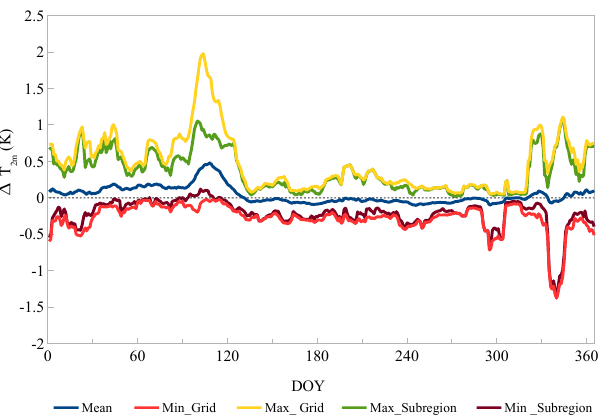
Figure 6. Maximum, minimum and mean differences of grid point- wise and regionally averaged 11-day running mean of daily mean 2m air temperature over 15years in subregion1.